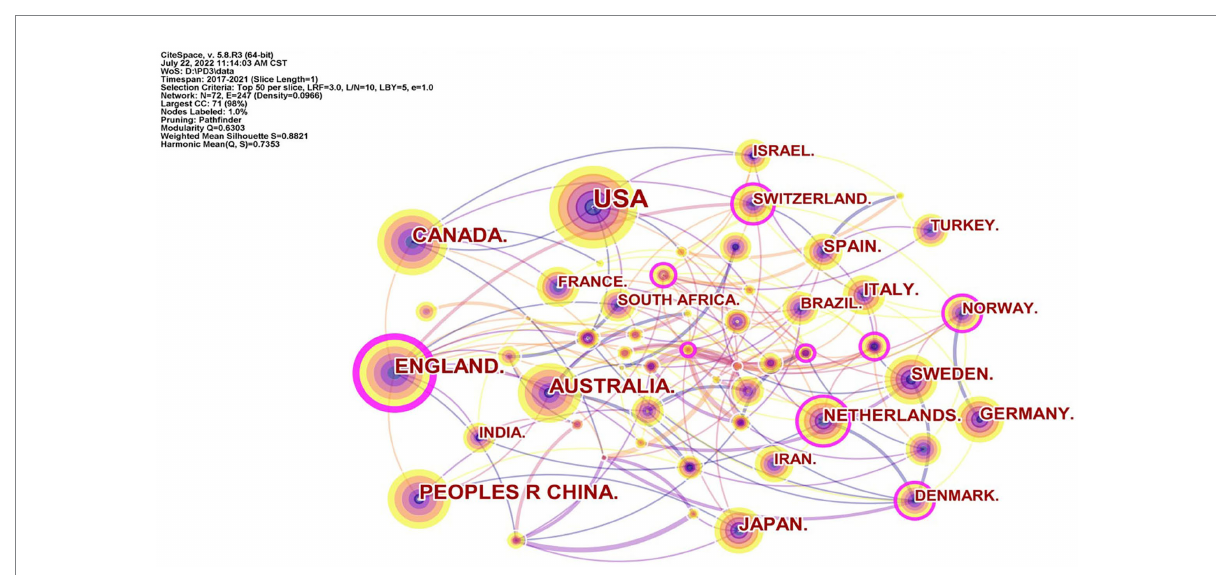
FIGURE 2 The cooperation network map of